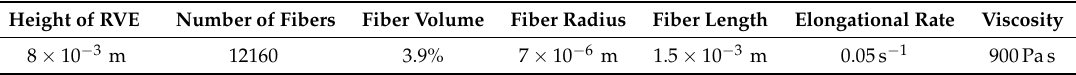
Table 4. Simulation parameters for comparison with the planar extensional flow experiment. Height of RVE Number of Fibers Fiber Volume Fiber Radius Fiber